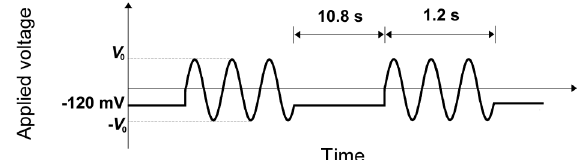
FIG. 6. Pulse protocol. A resting potential of (cid:2) 120 mV is maintained for 10.8 s in order for the channels to recover fully from inactivation. The resting potential of (cid:2) 120 mV is followed by a sinusoidal signal centered around 0 mV lasting for 1.2 s. The control parameters of the experiment are the amplitude and the frequency of the sinusoidal